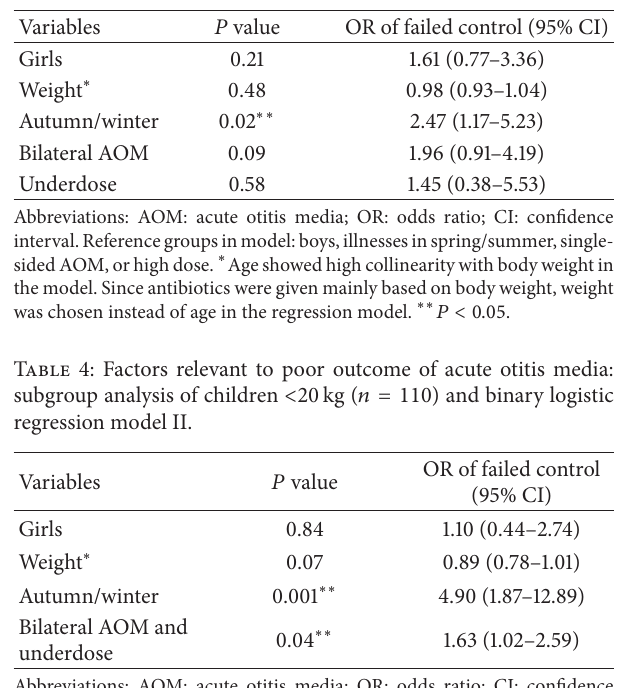
Table 3: Factors relevant to poor outcome of acute otitis media ( 𝑛 = 165 ) by multivariate analysis (binary logistic regression model).